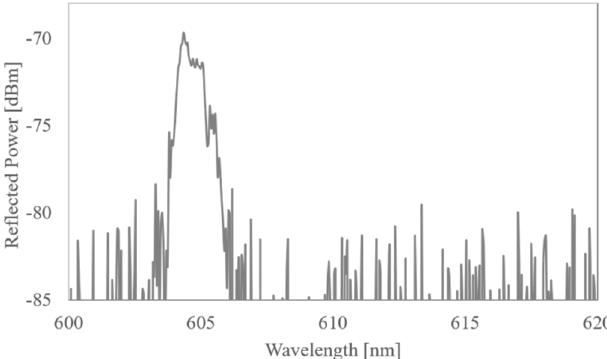
Figure 4. Reflected spectrum of the FBG in cyclic transparent amorphous fluoropolymers (CYTOP) fiber; image adapted from [58].